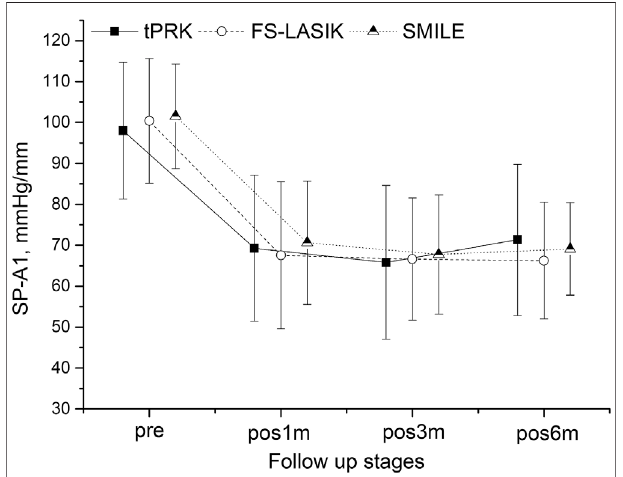
FIGURE 2 | Changes in the integrated inverse radius (IIR) throughout all follow-upstagesinthetPRK,FS-LASIK,andSMILEpatientgroups(meanand standard